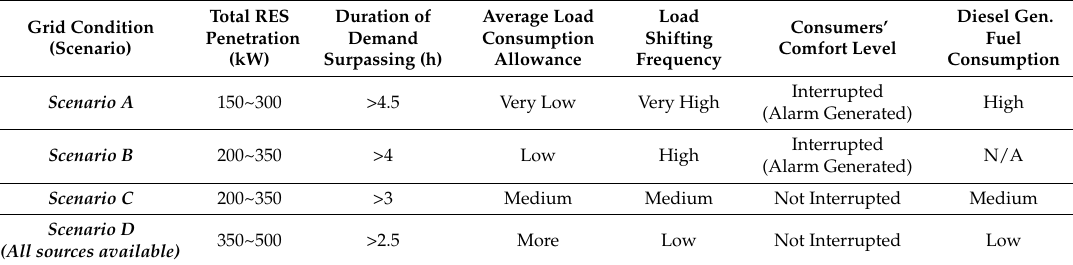
Table 4. Feedback of HEMS system under various grid